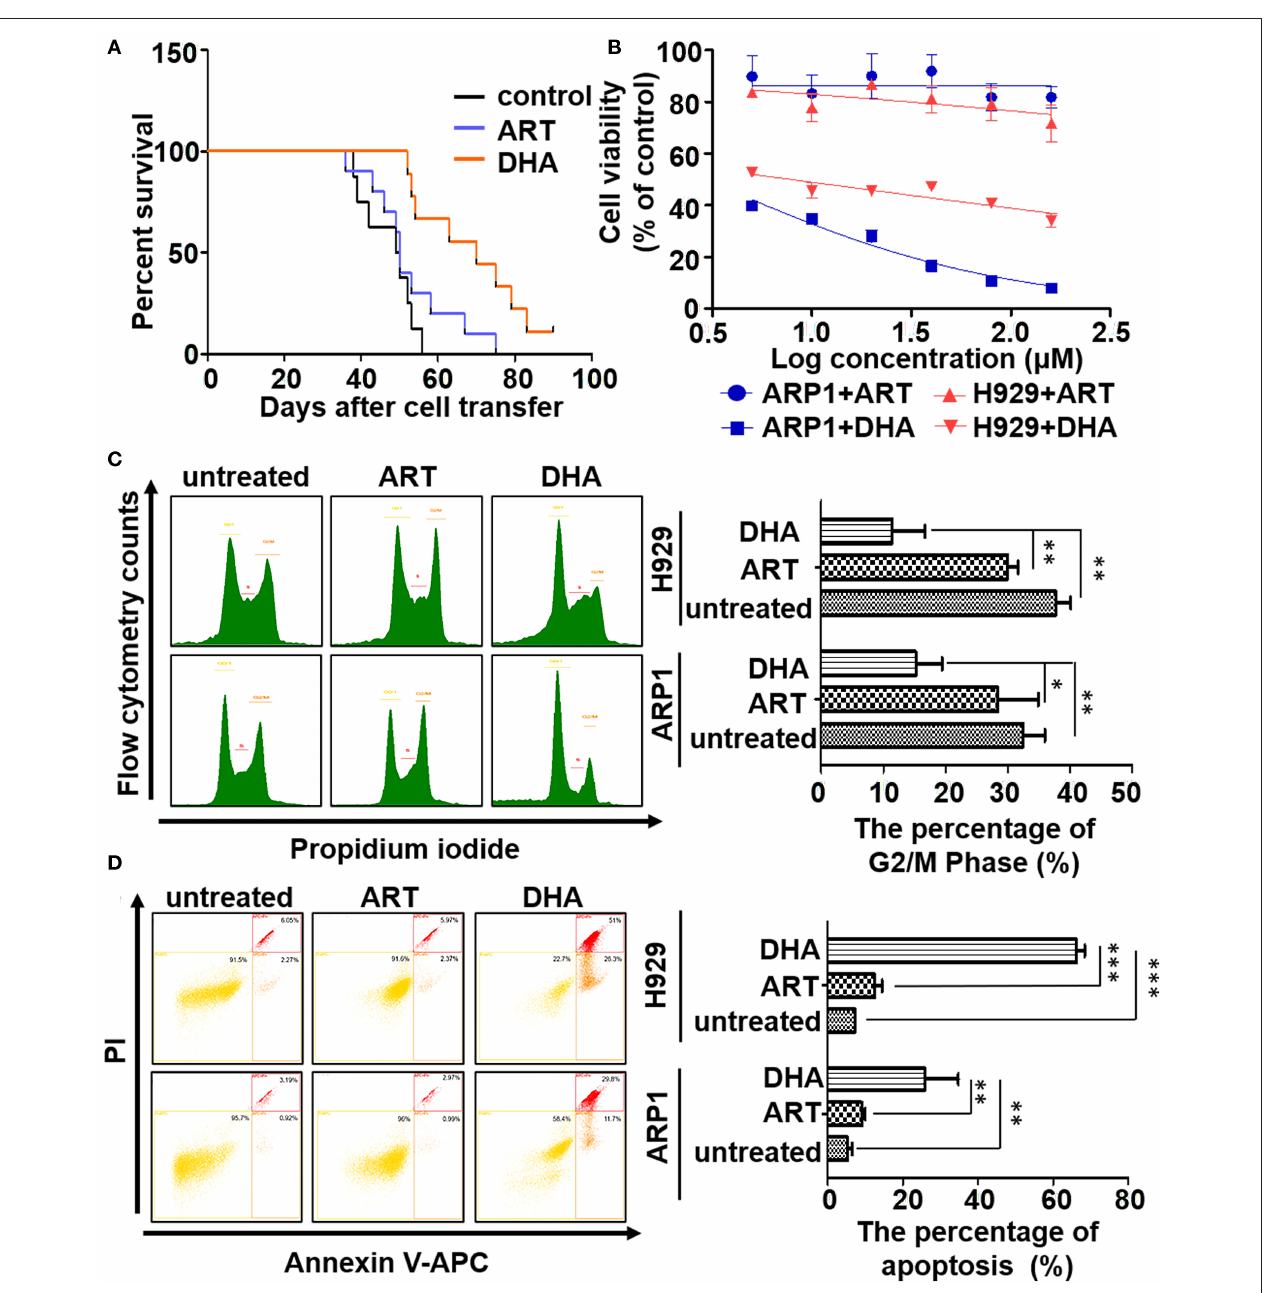
FIGURE 1 | DHA is a potential drug in the treatment of myeloma. (A) The survival data was obtained using 5TMM3VT myeloma mice model. (B) The MTT assay. DHA could suppress the proliferation of ARP1 and H929 cells, while ART could not. (C,D) The cell cycle and apoptosis of MM cells with or without treatment of either DHA or ART were determined by flow cytometry. The difference of the cell cycle of G2/M phase or apoptosis between groups was calculated by Student’s t -test. * P < 0.05, ** P < 0.01, and *** P < 0.001 were considered statistically significant.